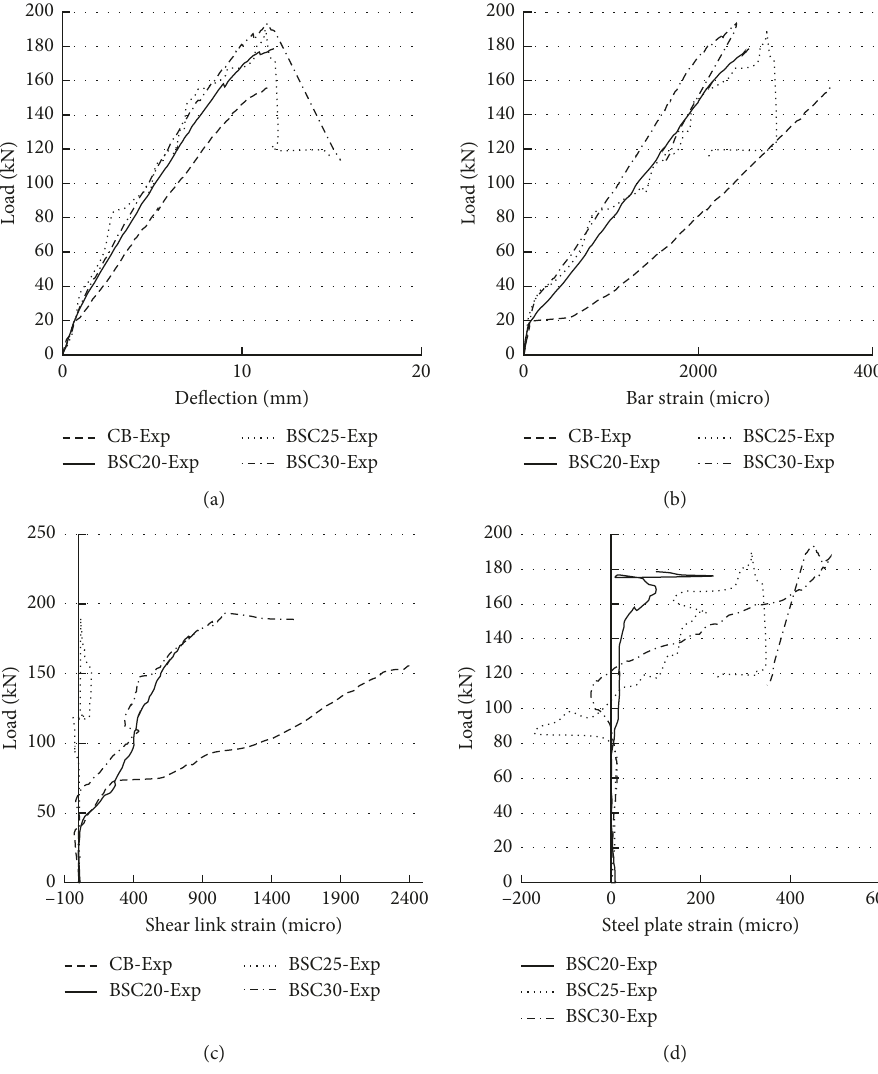
Figure 5: Experimental results on optimal shear-strengthened beam plate: (a) experimental deflection of beams; (b) experimental strain of flexural bar; (c) experimental strain of shear link; (d) experimental strain of steel